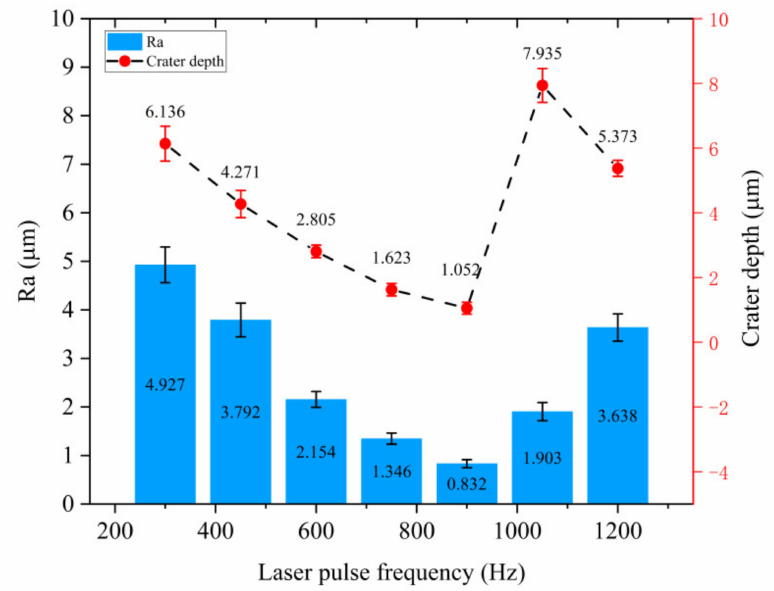
Figure 16. Effect of laser pulse frequency on the surface roughness of the samples.